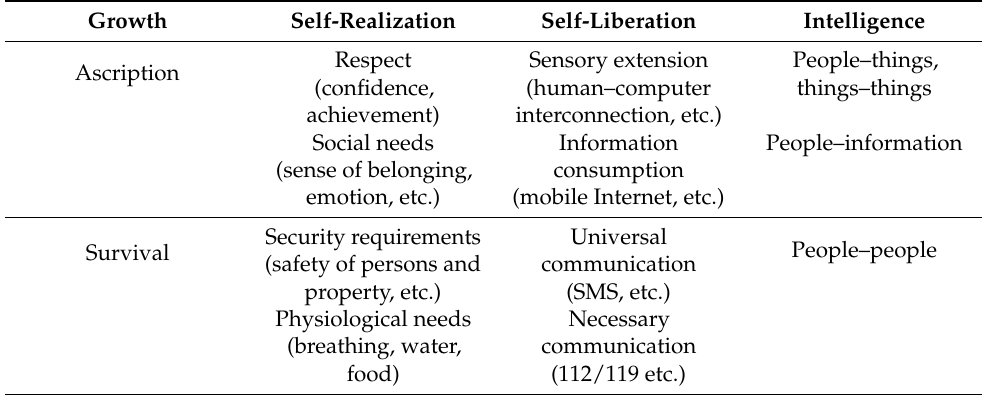
Table 1. Theory of telecommunications needs analogous to Maslow’s Hierarchy of Needs. Growth